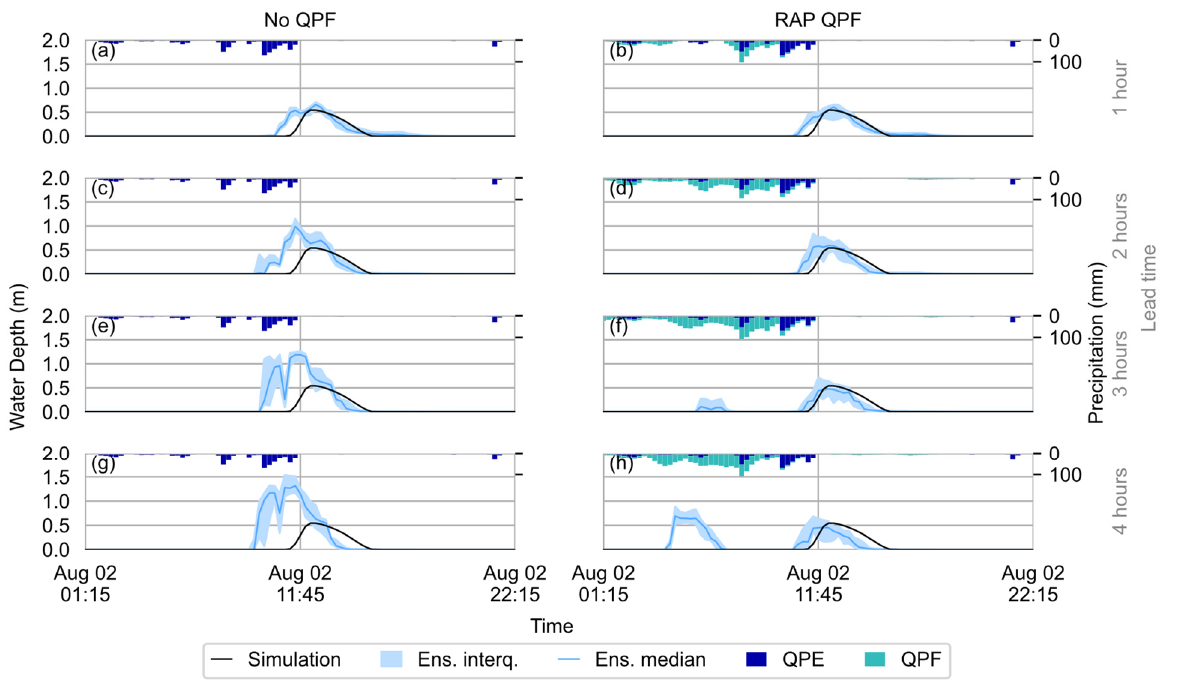
Figure 14. Water depth simulated and ensemble forecasts for POI 1 at lead times of ( a , b ) 1 h, ( c , d ) 2 h, ( e , f ) 3 h and ( g , h ) 4 h for the event of 2 August 2020.